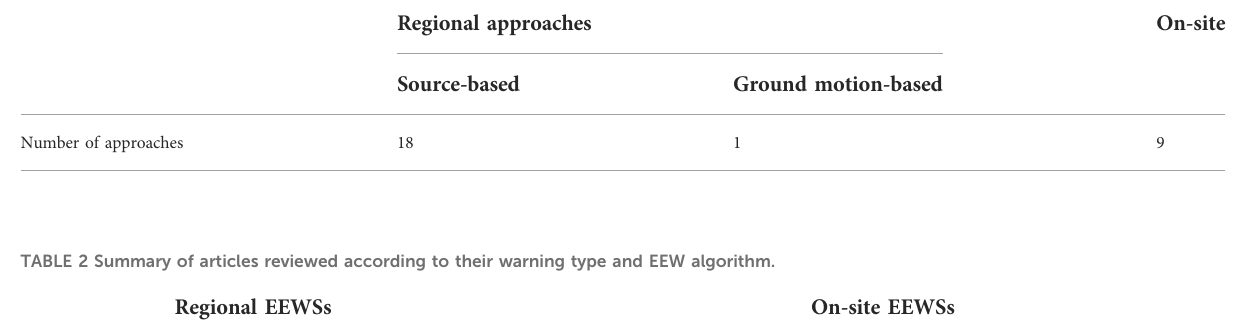
TABLE 1 Number of approaches presented in the reviewed articles based on the proposed classi fi cation.